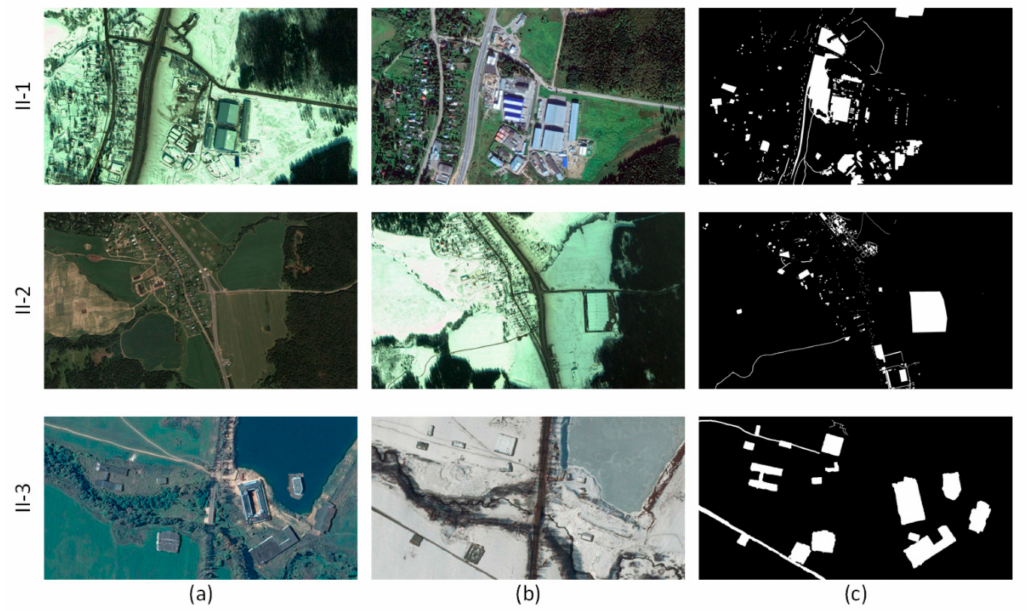
Figure 7. Overview of dataset II with major seasonal variation and corresponding reference change maps: ( a ) pre-event images, ( b ) post-event images, ( c )